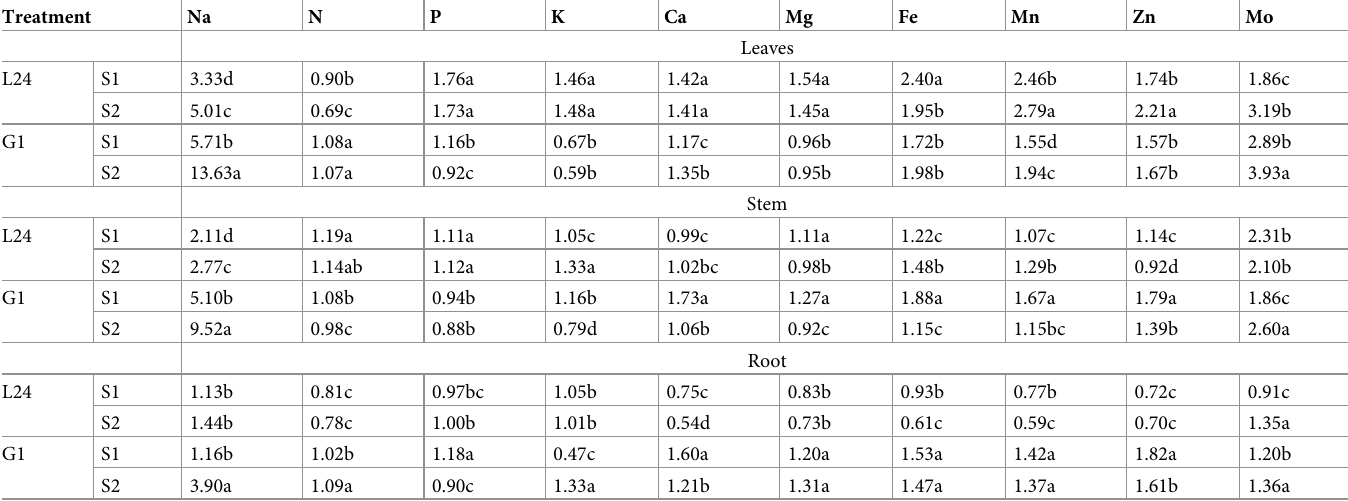
Table 3. The relative content of elements in leaves, stem and root of two cotton varieties under saline stress.